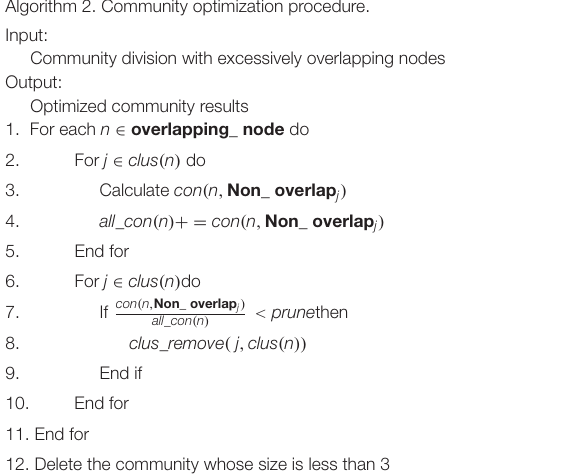
Algorithm 2. Community optimization